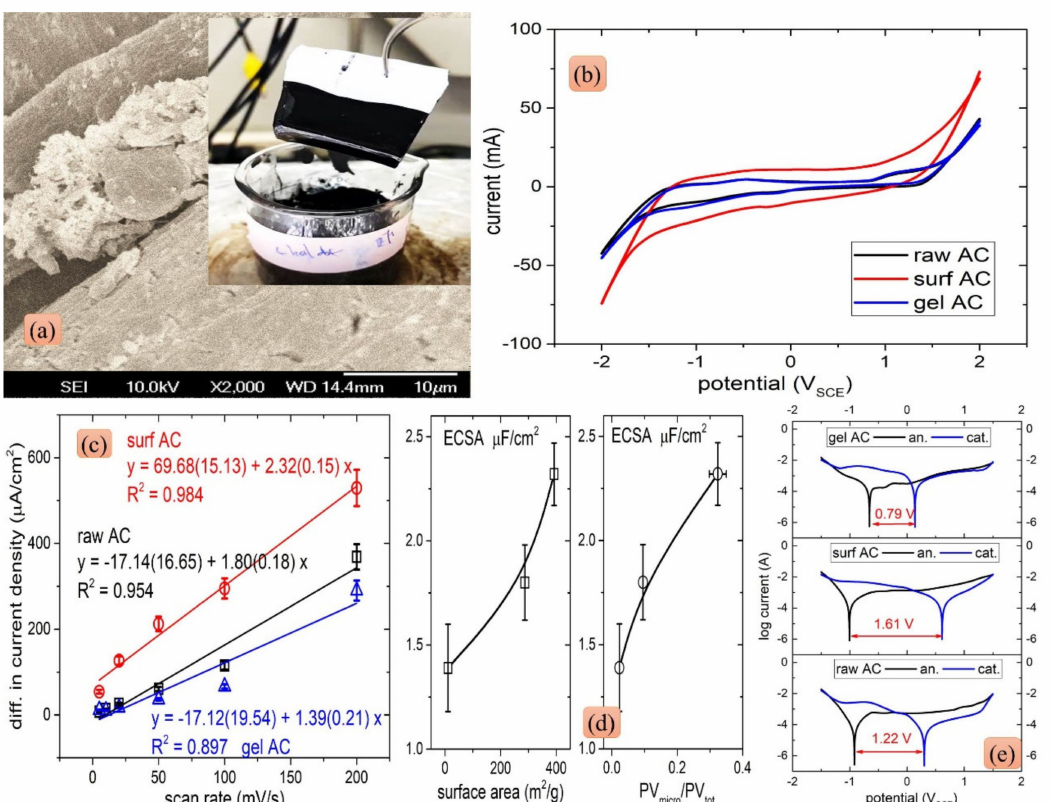
Figure 6. ( a ) SEM image of the as-obtained gel AC electrode, insert: photograph of the dipping process in electrode preparation; ( b ) CV scans of the as-obtained raw, surf, and gel AC electrodes; ( c ) difference in the anodic/cathodic capacitive currents ( ∆ J = Ja − Jc) at 0.10 V SCE against the scan rate. The slopes were obtained by linear regression; ( d ) correlation between the determined ECSA and the surface area (left) and PV micro /PV tot (right); ( e ) Tafel plots of the as-obtained raw, surf, and gel AC